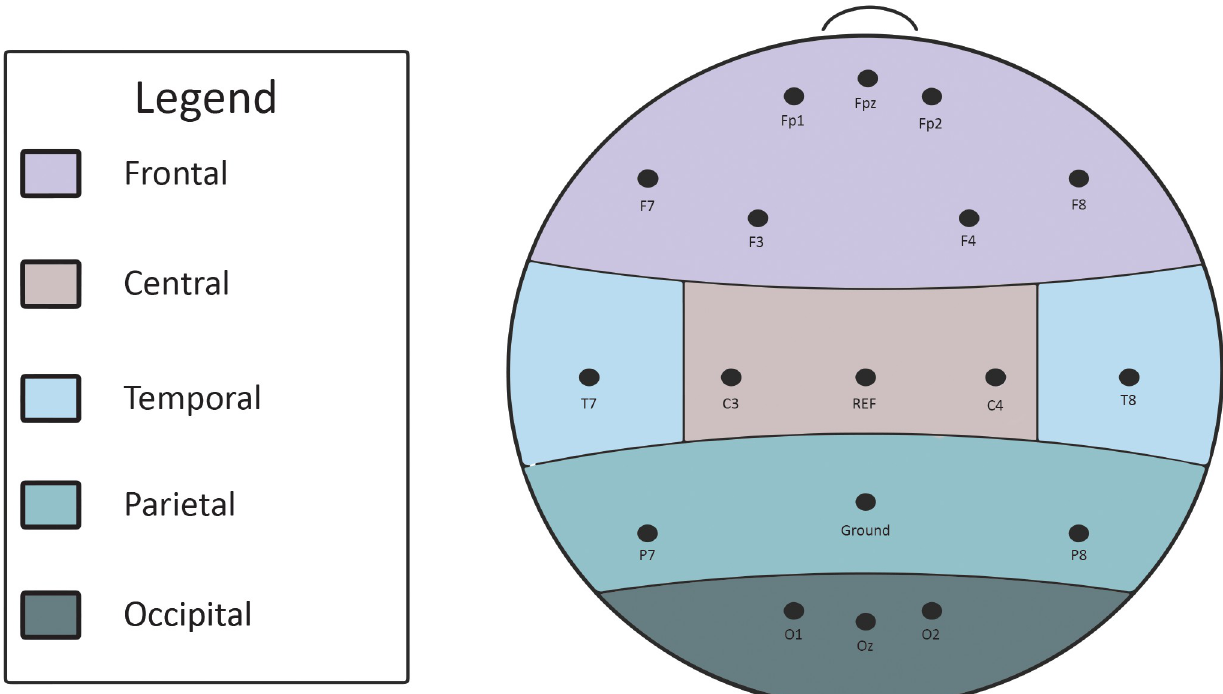
Fig 1. Electrode configuration for the EEG data collection.